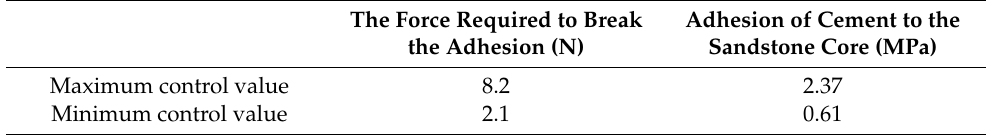
Table 3. Baseline adhesion between hardened cement slurry and rock